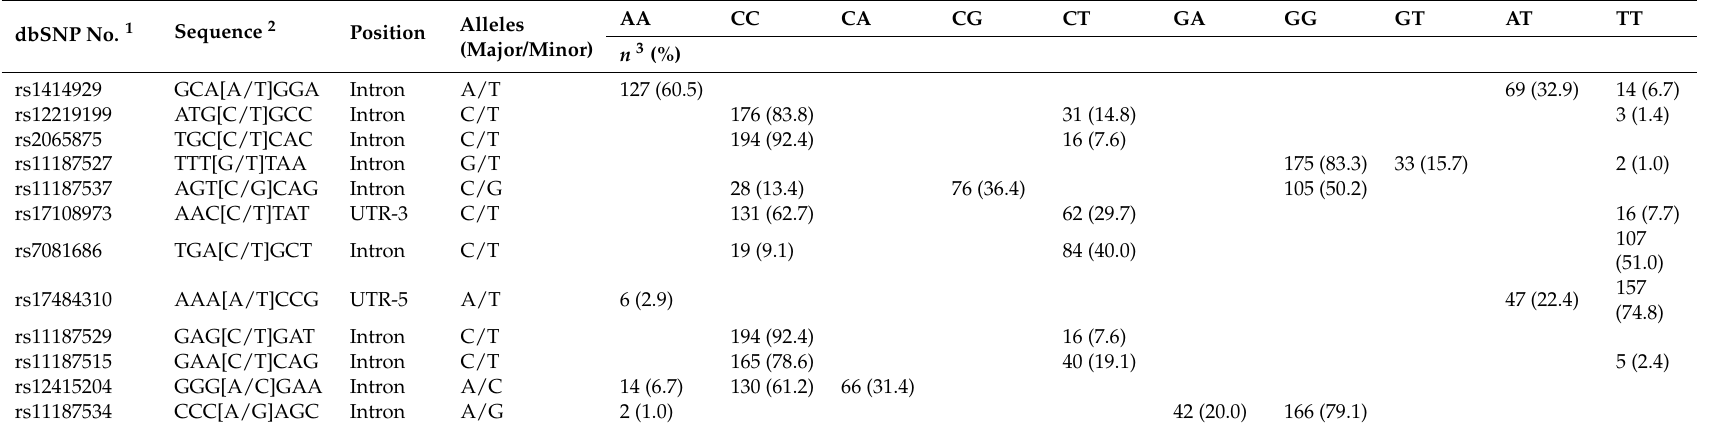
Table 1. Description of selected SNPs in